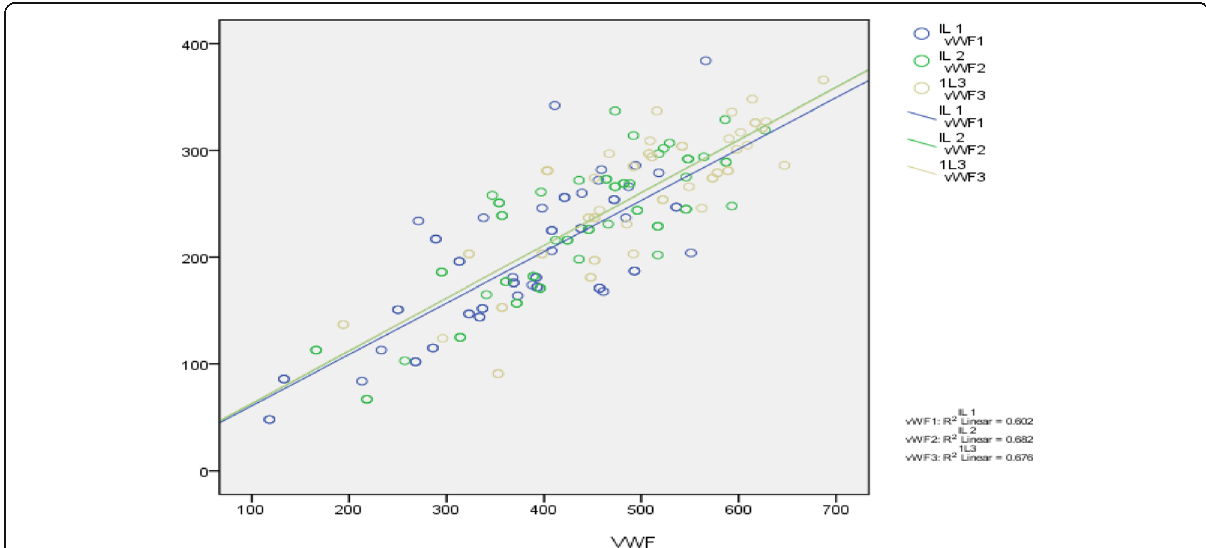
Fig. 2 Correlation between IL6 and vWF levels in ARDS patients. IL 1-VWF 1 (first reading at day 0) T0; IL 2-VWF 2 (day 2 reading) T48; IL 3-VWF 3 (day 3 reading)